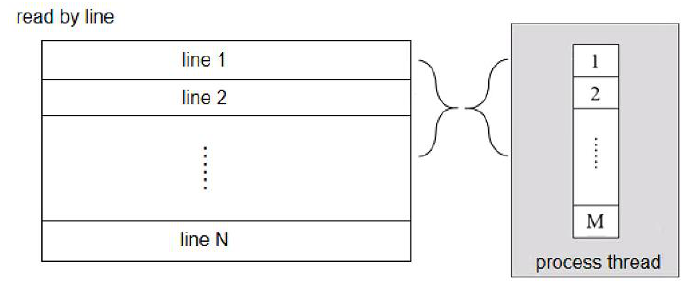
Figure 5. The parallelization strategies for Sentinel-1 interferometry processing.